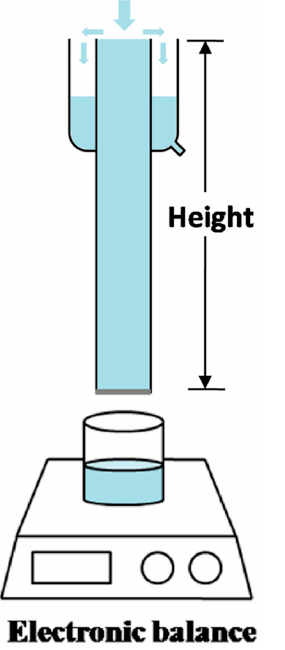
Figure 9. Schematic setup for the octane or water permeation tests.